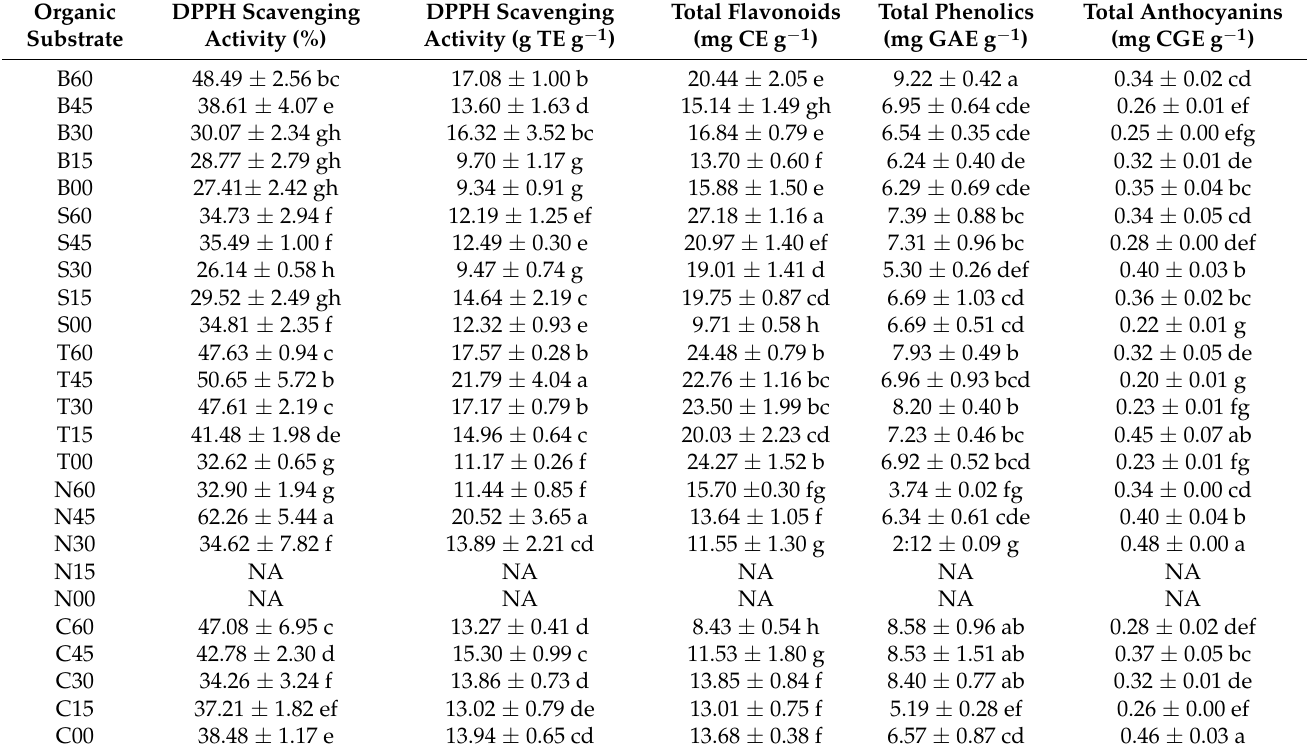
Table 3. Antioxidant activity (percentage DPPH and trolox equivalent DPPH), total phenolics, total flavonoids, and total anthocyanins of parsley grown on different organic substrates 1